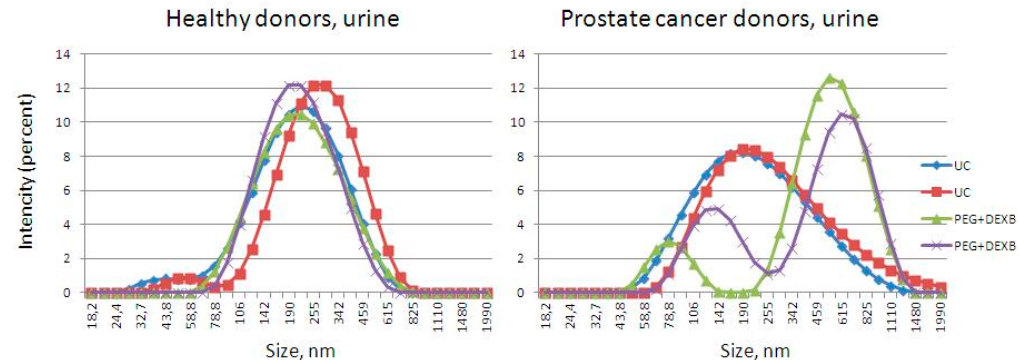
Figure 3. The size distribution of urine EVs isolated by precipitation (PEG+DEXB) and ultracentrifugation (UC), visualized by Zetasizer Nano ZS.